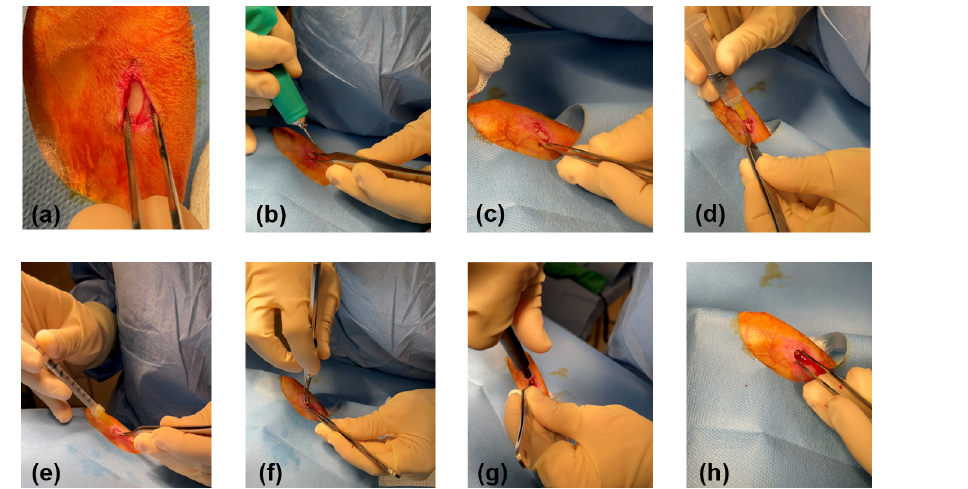
Figure 2. Surgical procedure: an incision was made over the left medial tibia, and the smooth flat portion was exposed (a) ; using a micro drill, a hole was created through the cortical bone into the medullary cavity (b, c) ; a total of 2mL of water (d) followed by 0.6mL of lysin or lysin carrier (e) was injected; and a seeded implant was inserted (f) , tightened with a screwdriver (g) , and confirmed to be secure (h) .